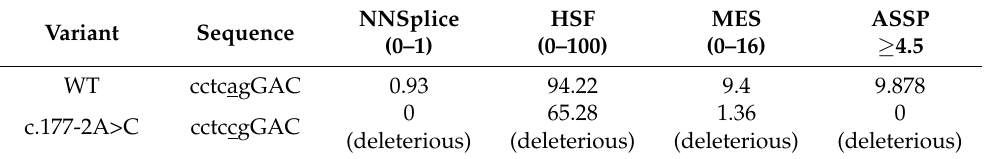
Table 3. In silico analysis of the variant c.177-2A>C TG .